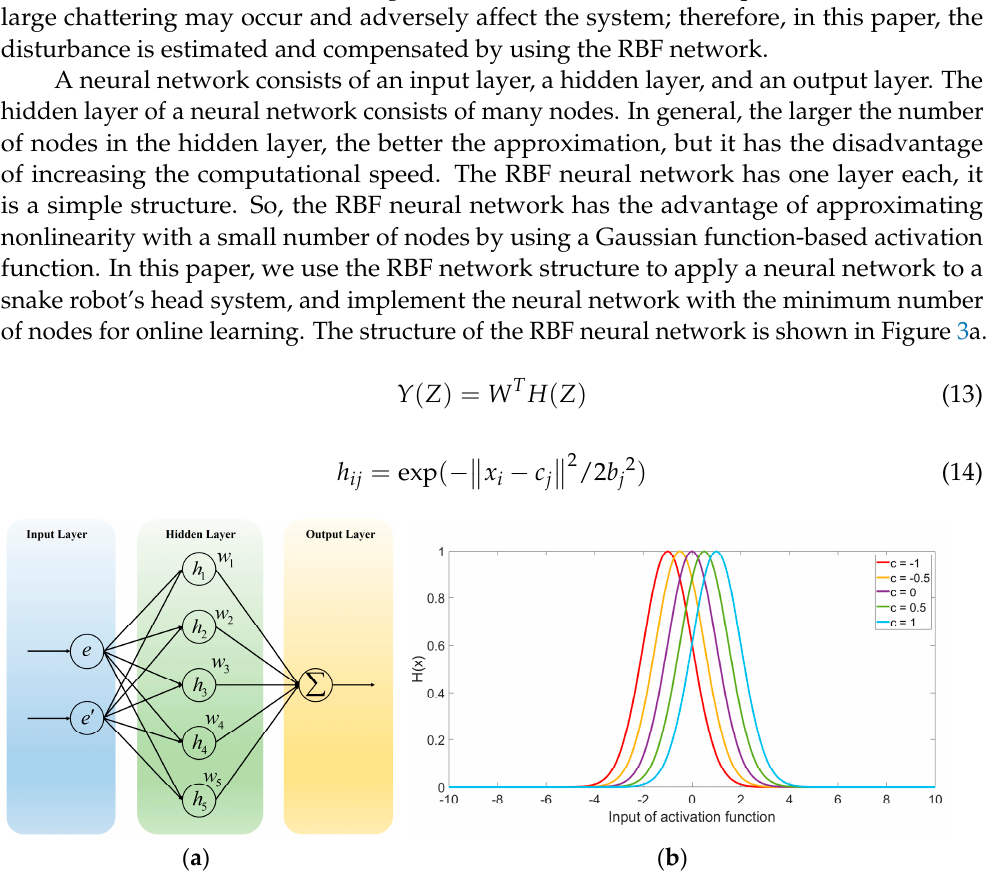
Figure 3. ( a ) RBF neural network; ( b ) output of Gaussian function.